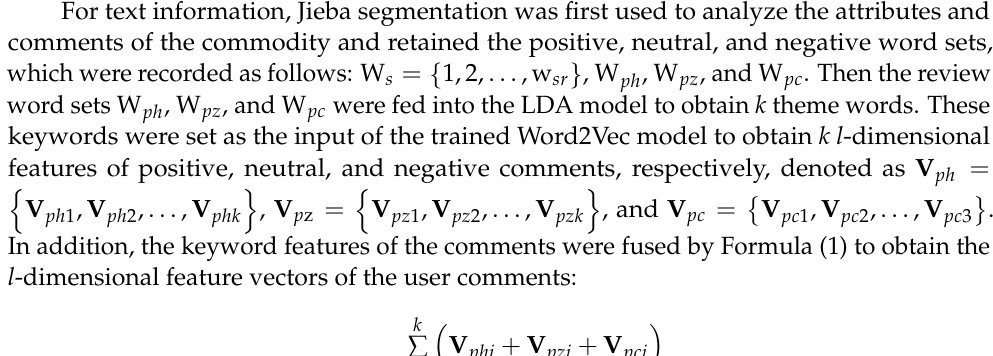
Figure 2. Keyframe stacking and input. The input dimension of MobileNetV2 is 3 × ( m + n )